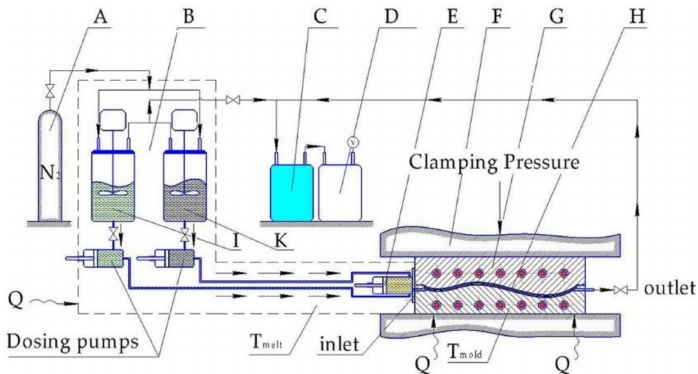
Figure 1. Scheme of the T-RTM process (A—nitrogen source; B—dosing unit; C—cold trap; D—vacuum pump; E—dynamic mixing head; F—mold carrier; G—metal mold; H—textile preform; I—tank with ε -caprolactam + initiator; K—tank with ε -caprolactam + activator